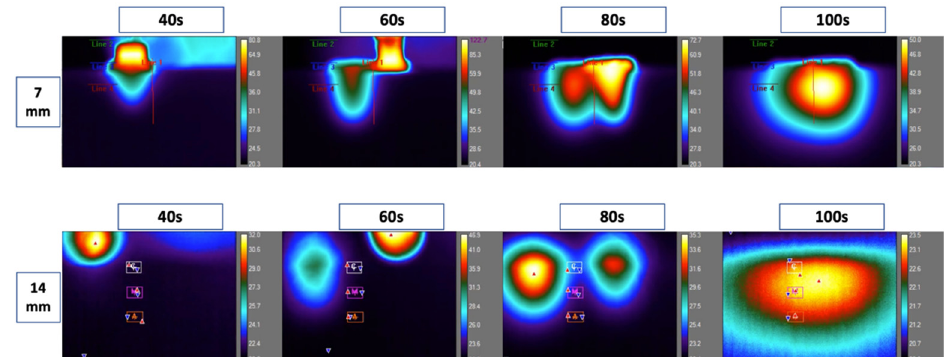
Figure 3. Thermal camera recordings from 7 mm and 14 mm inter-osteotomy distances at 40 s, 60 s, 80 s, and 100 s. This figure illustrates the live recording of the thermal behavior during the preparation of the osteotomies. The red line represents the center between osteotomies. Along the red